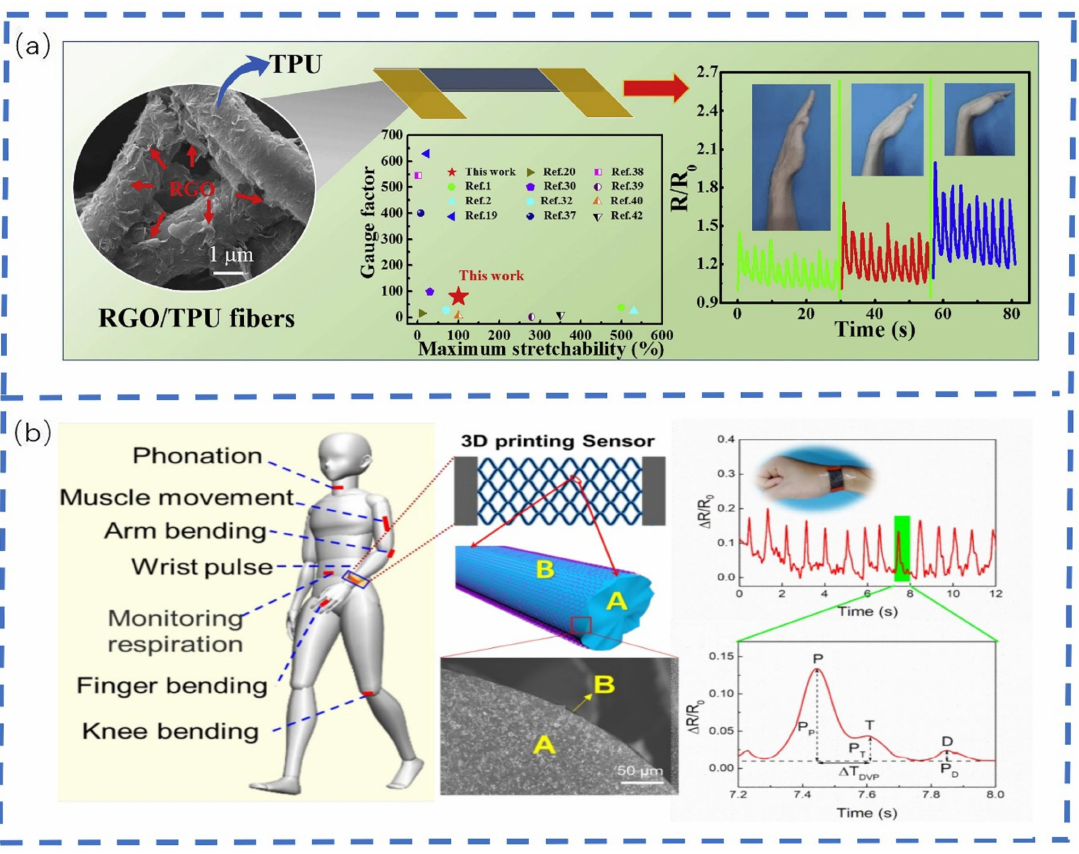
Figure 12. Application of flexible sensors for motion monitoring: ( a ) electron microscopy images of the surface and cross-section of the strain sensor and response curves on the wrist at different curvatures [176]; ( b ) self-compensating second-order structure high-sensitivity and large range strain sensor for human motion detection and its sensing position and corresponding overview